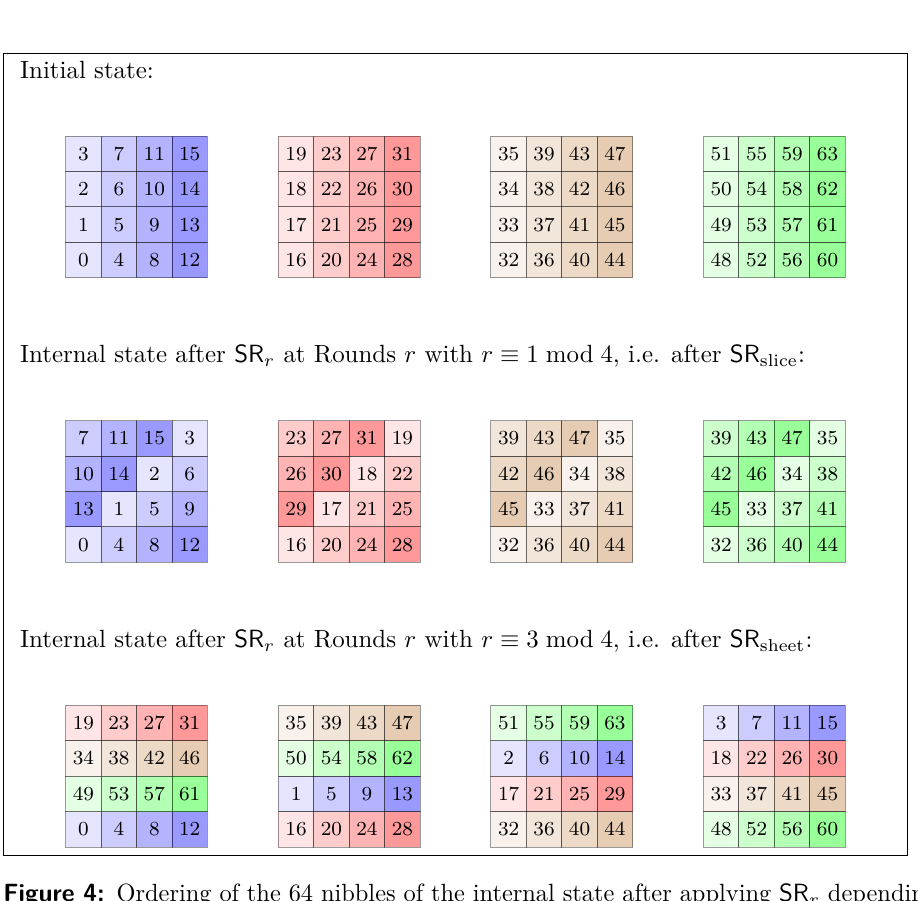
Figure 4: Ordering of the 64 nibbles of the internal state after applying SR 𝑟 depending on 𝑟 mod 4, when the cube is represented as the collection of its 4